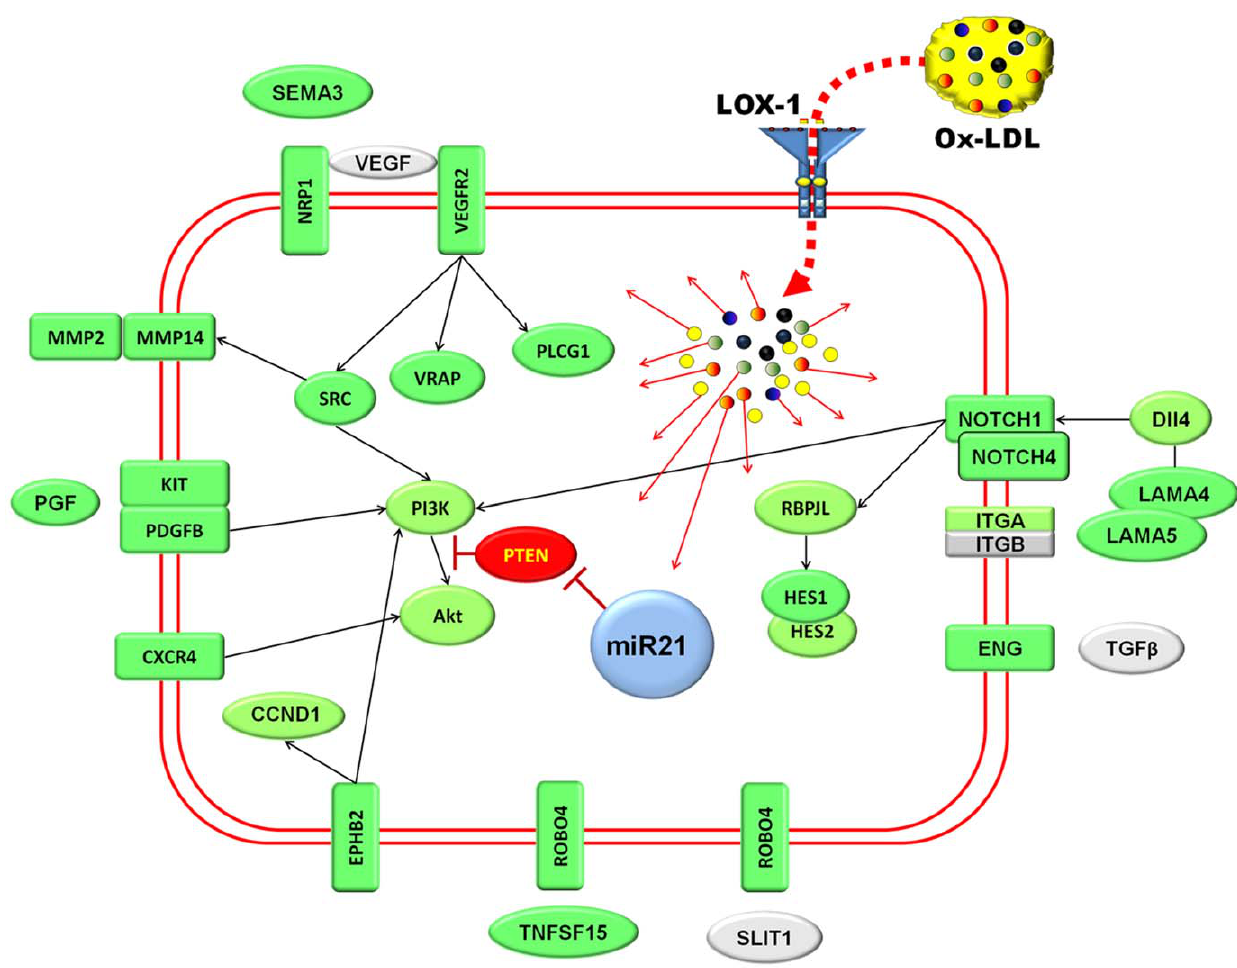
Figure 6. Schematics of pro-angiogenic signaling of ox-LDL based on microarray data partially validated by qPCR. Color coding: Shades of green – upregulation. Rred-inhibition; Grey –no change; Pro-angiogenic action of ox-LDL appears to be most consistently associated with VEGF and Notch pathways. Downstream target genes of VEGF also show corresponding shifts in expression patterns.